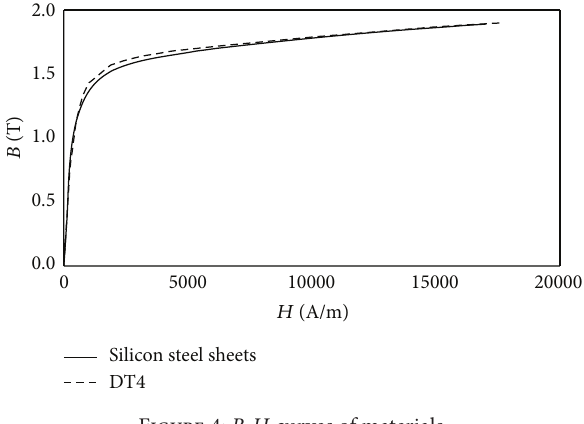
Figure 4: B - H curves of materials.